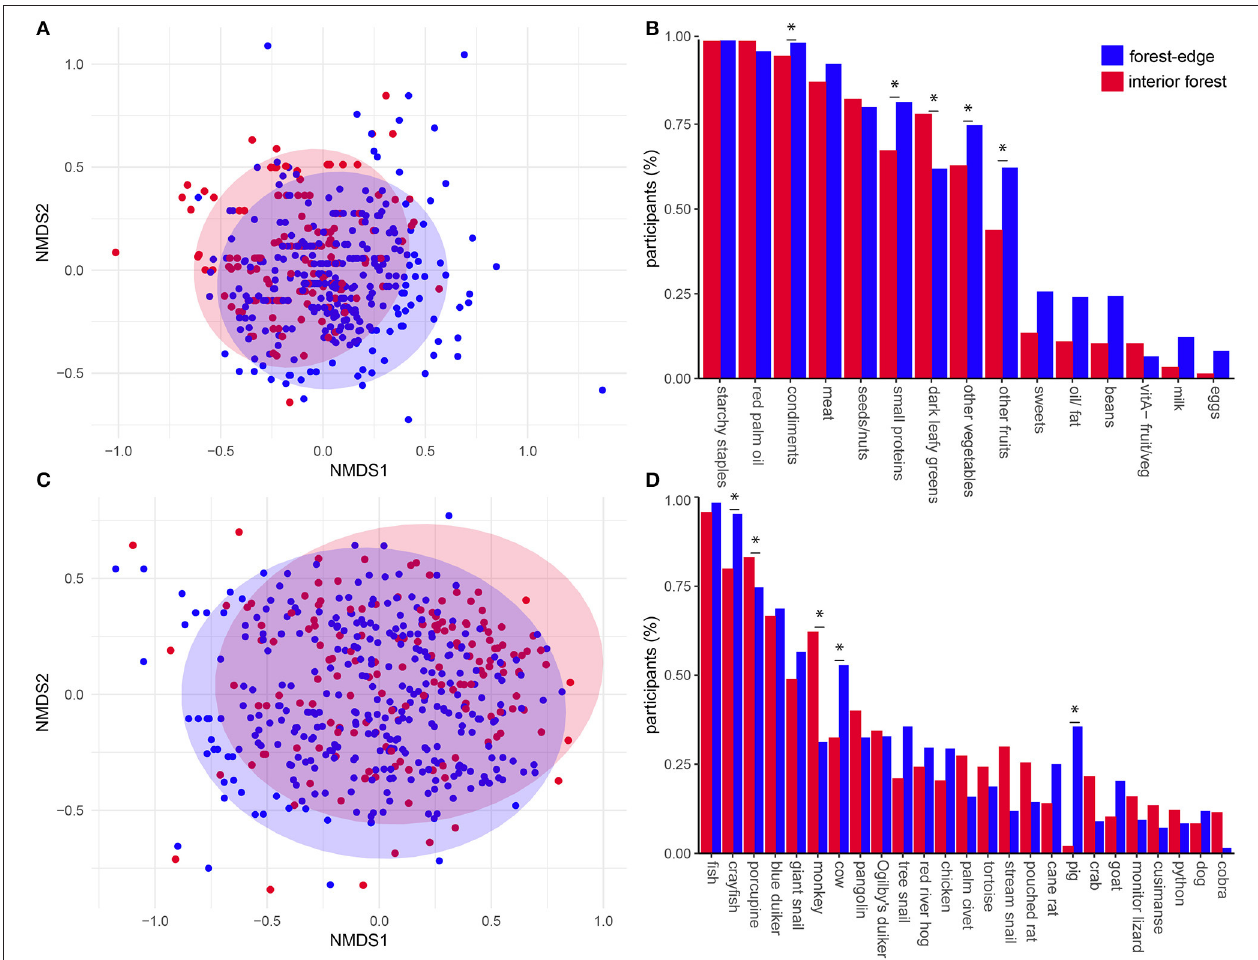
FIGURE 3 | Diet compositions of deep and forest-edge communities. Nonmetric multidimensional scaling (NMDS) plot of the first two axes of Jaccard distance matrices describing dietary composition from 24-h recall data (stress = 0.11, k = 4) (A) and bushmeat composition from 30-day recall data (stress = 0.16, k = 3) (C) . Plots are comparing dietary compositions of individuals in interior (red) and forest-edge (blue) forest communities. Barplots compare relative frequency of consumption of food items from each food category (B) and different animals (D) between locations (items with relative frequency < 0.05 not shown). Asterisks indicate indicator foods with IV > 0.3 and p < 0.05 of deep and forest-edge